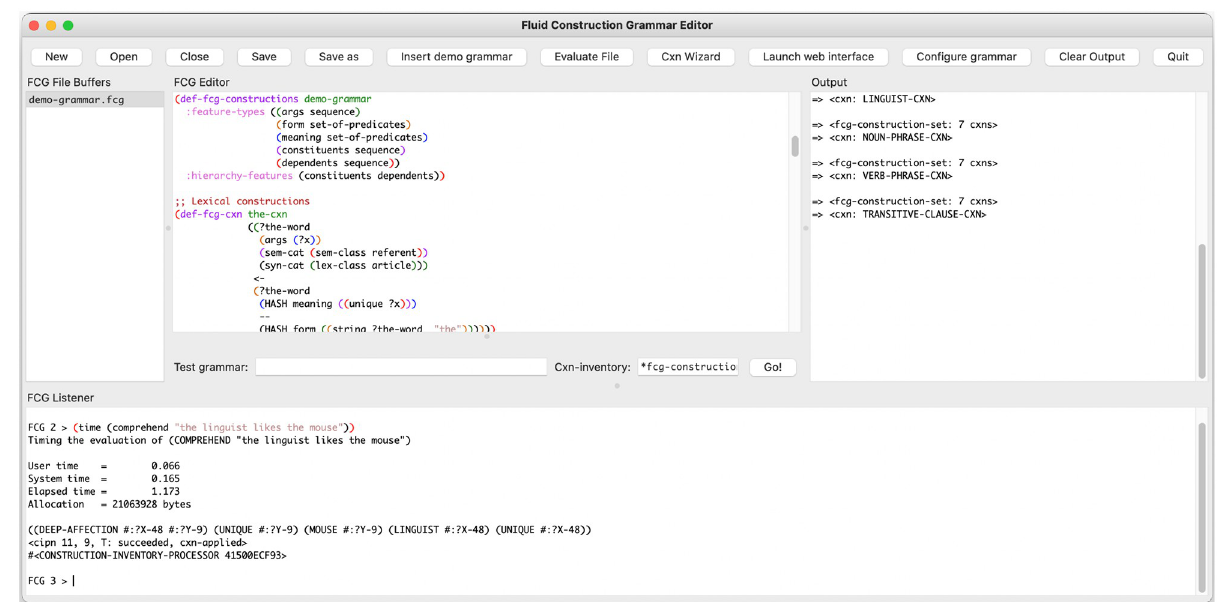
Fig 5. FCG listener. The FCG listener can be used to programmatically interact with a grammar, in this case timing the comprehension process of the utterance “ the linguist likes the mouse ” using the demo